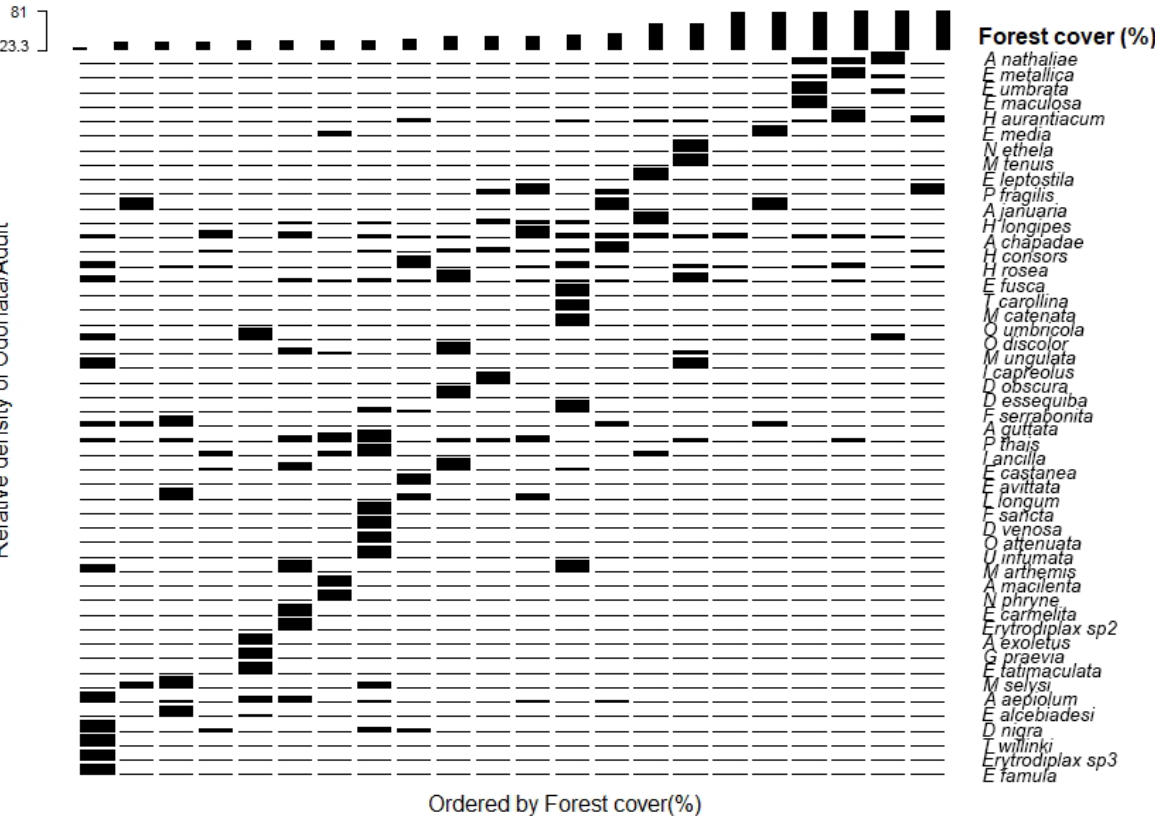
Figure 2. Relative abundance of adult individuals of Odonata with the amount of forest cover (%) for the streams sampled in cabruca areas.